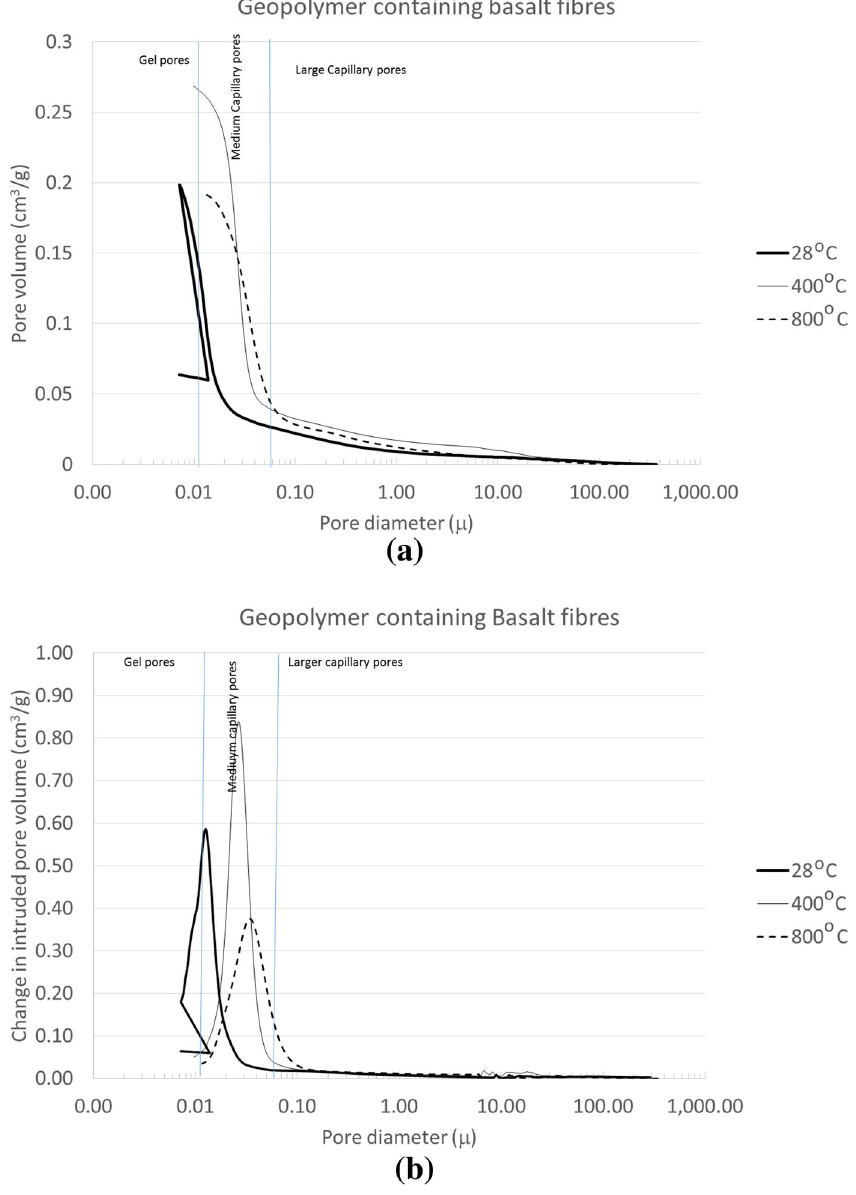
Fig. 9 Pore volume distribution of 1 wt% carbon and basalt fibre reinforced geopolymer at ambient and at various elevated temperatures. a Carbon fibre reinforced geopolymer composite and b Basalt fibre reinforced geopolymer